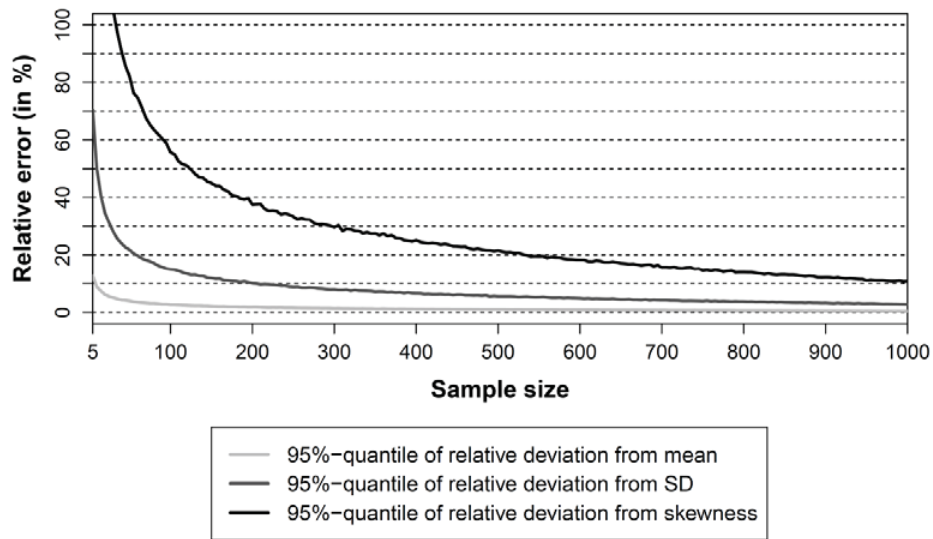
Figure 2. Relative error of estimated statistical moments as a function of sample size. Simulations of winterwheat yields at Payerne under Baseline climate conditions.